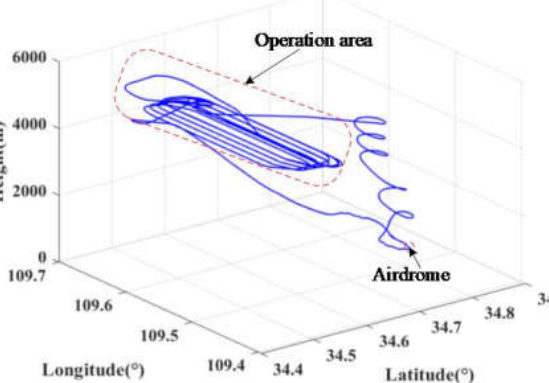
Figure 3. The flight experimental setup.